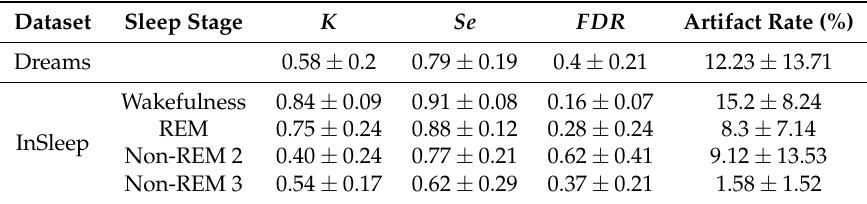
Figure 5. Scoring obtained by the benchmark method (RP) and RPs (RPS) on data from the Dreams dataset. Normalized distances to four clusters obtained for this recording with RPs (CL1–4) are shown, as well. Artifacts (Expert) are denoted with the solid blue line. Table 2. Performance of the benchmark artifact detection method.